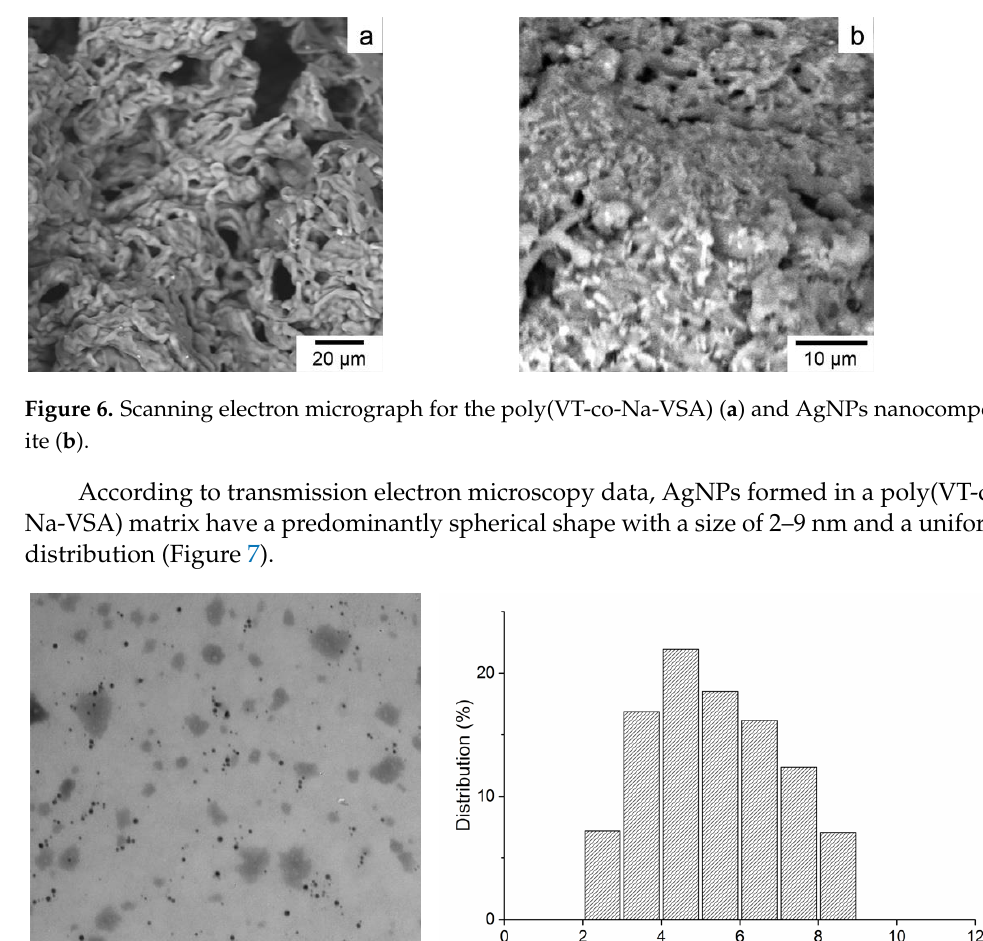
Figure 5. UV – Vis spectra for nanocomposite with AgNPs stabilized by poly(VT-co-Na-VSA).